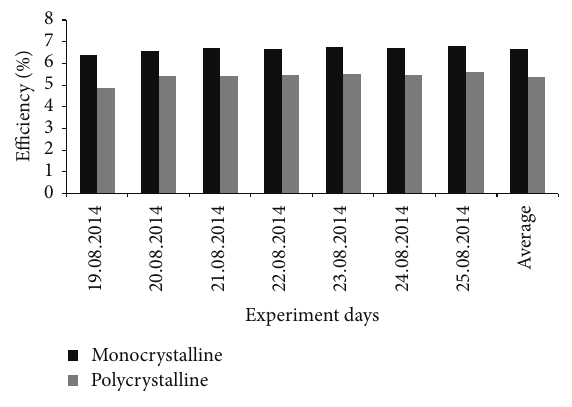
Figure 7: Panels efficiencies